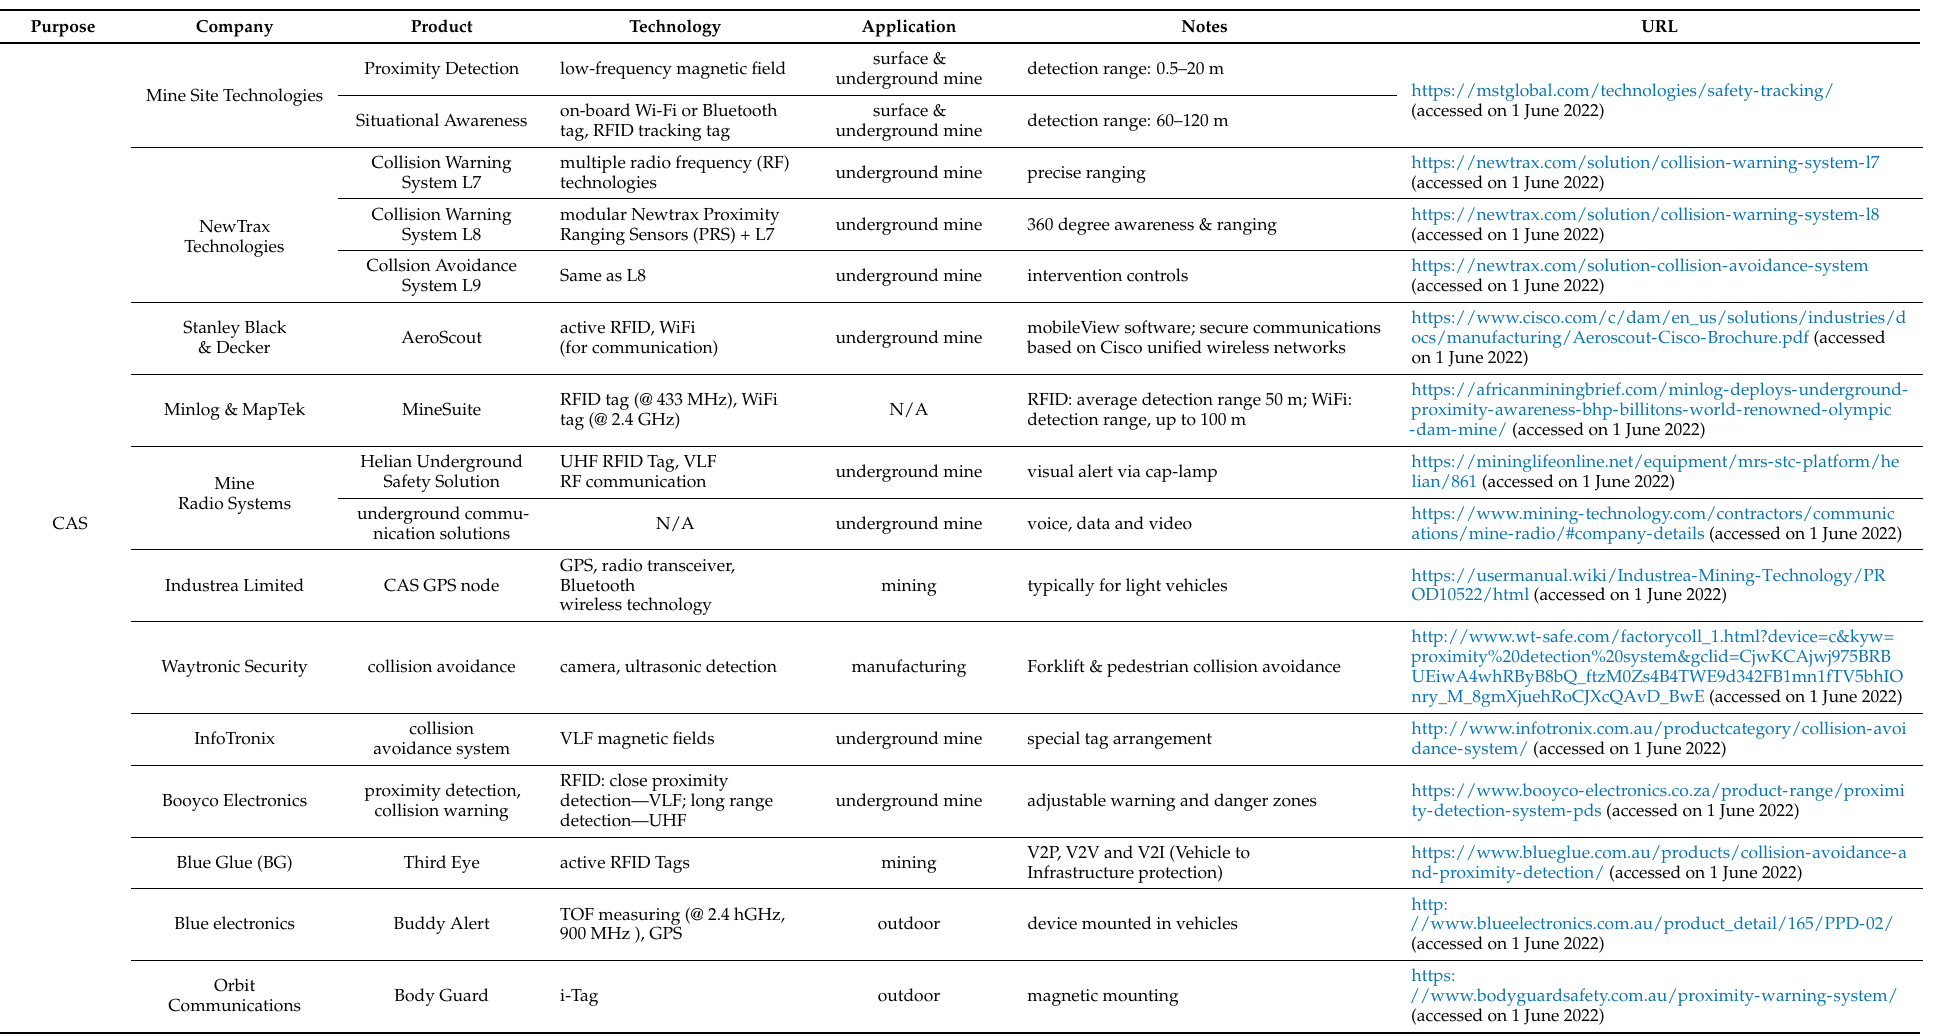
Table 2. Summary of Commercially Available CAS